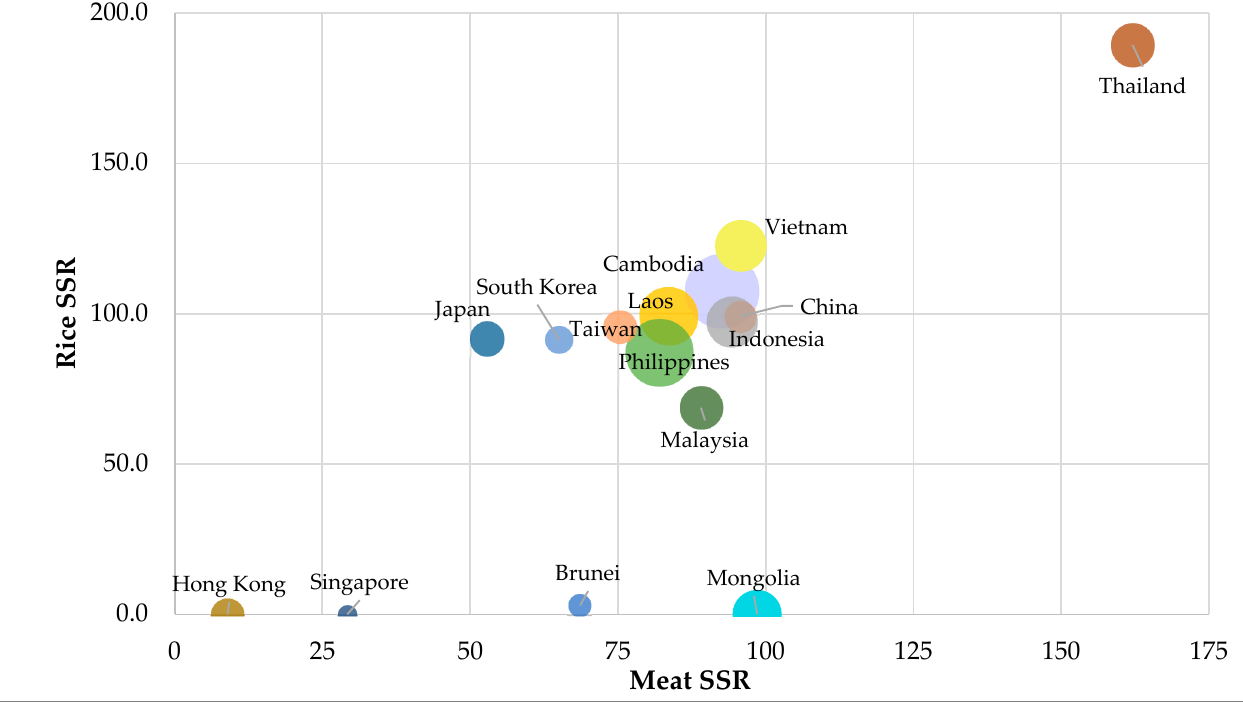
Figure 2. Relationship between the meat SSR (2017–2019), rice SSR (2017–2019), and share of expenditure on food in total GDP (2017) for East and Southeast Asian economies (Source: data retrieved and adapted from [4]). Note: the area of each bubble signifies the share of expenditure on food in the total GDP of each economy. Data on self-sufficiency for North Korea are not available.